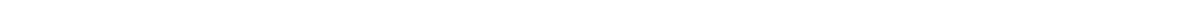
Fig. 4 The autophagy inhibition caused by high cell density is myosin II – dependent. a Representative LC3-II western-blots of HeLa cells overexpressing either the wild-type or the constitutively active MLC2 (T18D, S19D — mut) construct. The graphs show the LC3-II/GAPDH: means ± s.d. ( n = 3; * P < 0.05; two-tailed one sample t -test). b Representative LC3-II western-blots of high con fl uency HeLa cells overexpressing either the wild-type or the constitutively active MLC2 (T18D, S19D - mut) construct. The cells were exposed to BafA1 (400 nM). The graphs show the LC3-II/GAPDH: means ± s.d. ( n = 3; ** P < 0.01; two-way ANOVA). c Representative HA-htt Q74 aggregates in high con fl uency HeLa cells overexpressing either the wild-type or the constitutively active MLC2 (T18D, S19D - mut) construct. The graphs show the percentage of cells with HA-htt Q74 aggregates: means ± s.d. ( n = 3; *** P < 0.001, NS, not signi fi cant; two-way ANOVA). d Representative LC3-II western-blots of high con fl uency MCF10A cells overexpressing either the wild-type or the constitutively active MLC2 (T18D, S19D - mut) construct. The cells were exposed to either DMSO or BafA1 (400 nM). The graphs show the LC3-II/ GAPDH: means ± s.d. ( n = 3; *** P < 0.001, ** P < 0.01, * P < 0.05; two-way ANOVA). e Representative LC3-II western-blots of HeLa cells